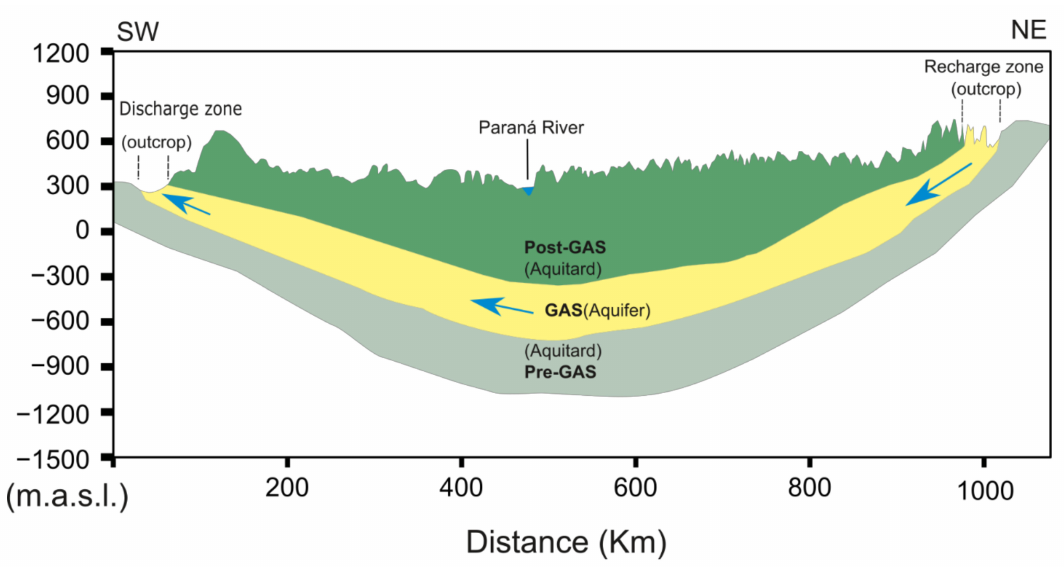
Figure 3. Schematic hydrogeological cross-section showing the adopted conceptual model of the Guarani Aquifer System. The blue arrows show the main groundwater flow